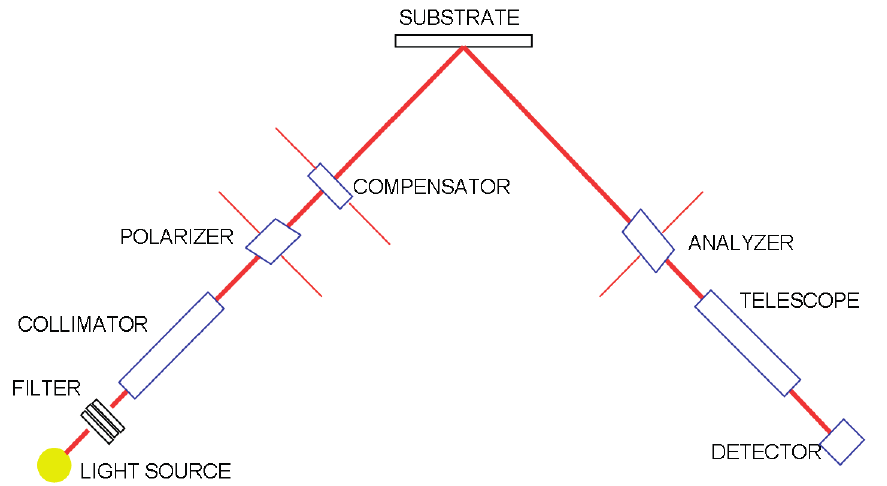
Figure 2. Diagram of thickness measurement by ellipsometry.